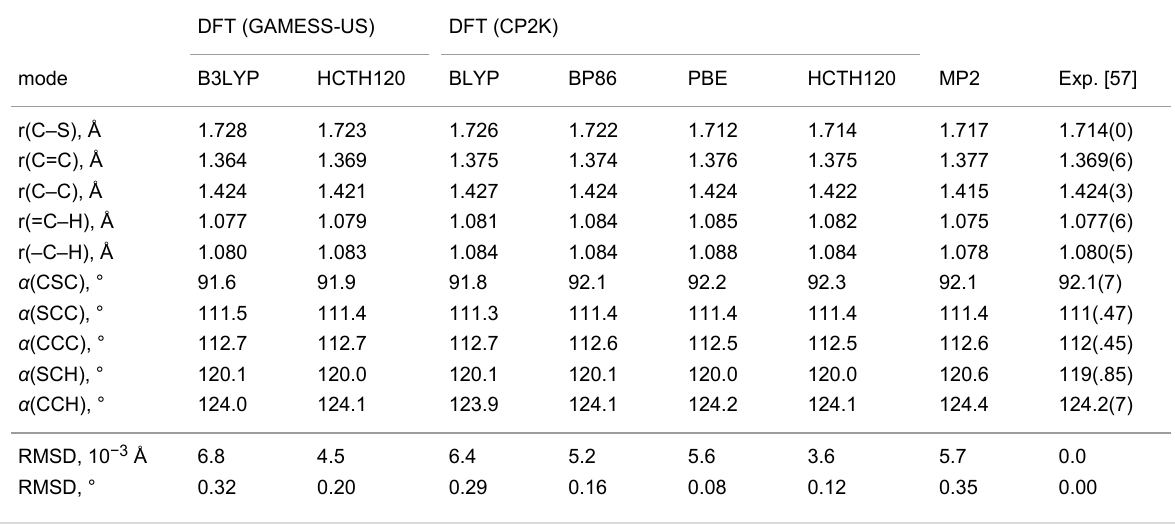
Table 3: Calculated and experimental molecular geometry of thiophene in the gas